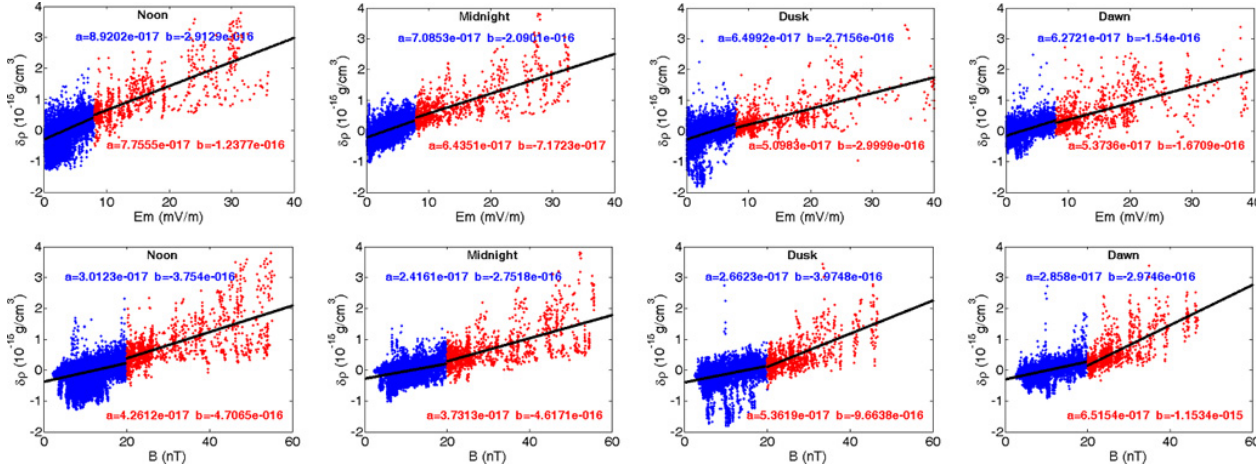
Fig. 15. Scatter point plot of the storm-time mass density changes versus the time shifted E m and B in different LT sectors at low and middle latitudes for the 35 storms studied. The linearly fitted lines are drawn separately over larger ( > 8mVm − 1 for E m and > 20nT for B ) and smaller ( < 8mVm − 1 for E m and < 20nT for B ) values of interplanetary parameters.